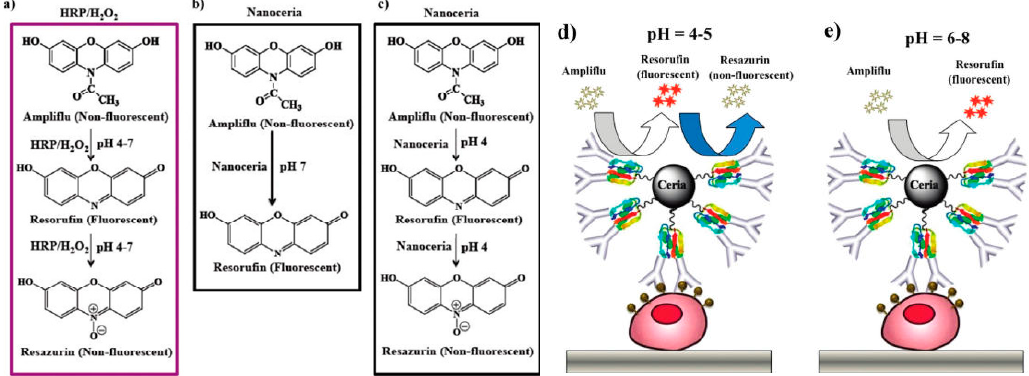
Figure 5. Schematic showing the HRP/H 2 O 2 and nanoceria mediated oxidation of ampliflu. (a) In the pH range of 4 – 7, HRP/H 2 O 2 oxidizes ampliflu to a nonfluorescent final product (resazurin); (b) in contrast, nanoceria oxidizes ampliflu to the intermediate oxidation fluorescent product (resorufin) at pH 7; (c) while at or below pH 5.0, nanoceria yields the terminal oxidized nonfluorescent product, resazurin; (d,e) the ability of nanoceria to oxidize ampliflu to a stable fluorescent product in the pH range of 6 – 8 will facilitate its use in ELISA without the use of H 2 O 2 . Reproduced with permission from [70]. Copyright American Chemical Society,